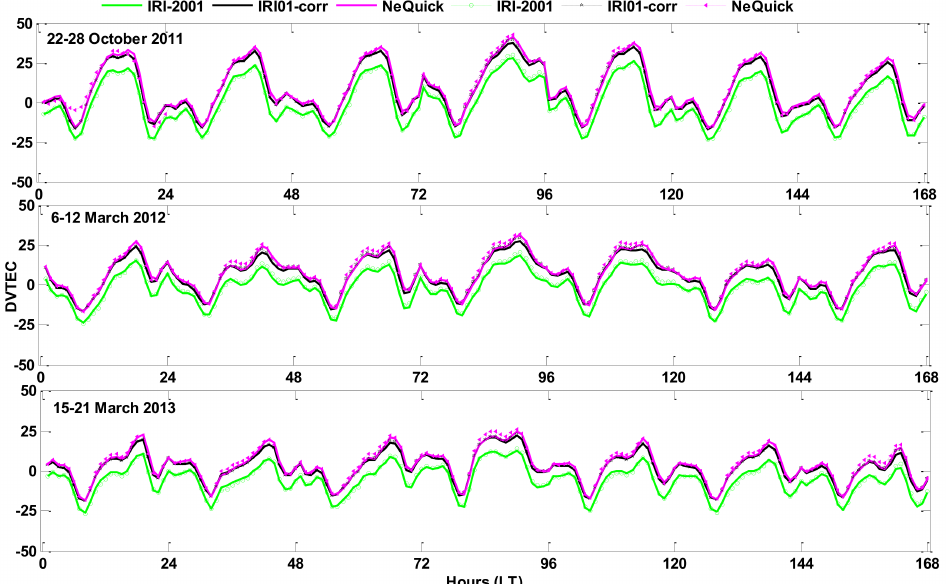
Figure 8. The daily variations of the DVTEC during the disturbed period. The IRI-2016 (IRI-2001, IRI01-corr, and NeQuick) are plotted in solid lines and the IRI-2012 (IRI-2001, IRI01-corr, and NeQuick) are plotted in dotted lines.